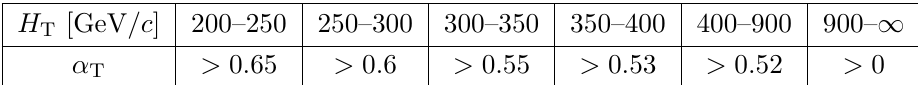
Table 4. Table detailing the H T -dependent (cid:11) T